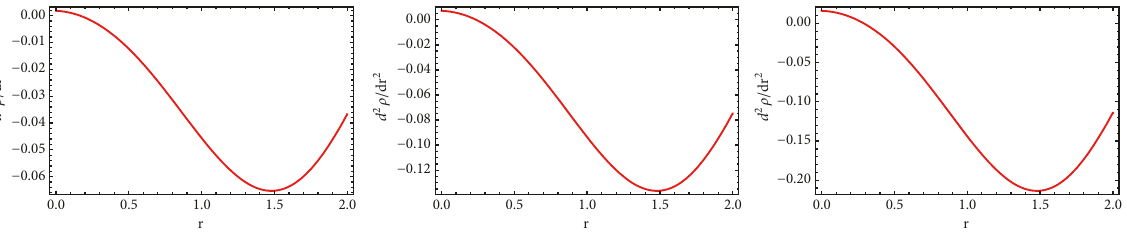
Figure 8: This figure represents the variation of 𝑑 2 𝜌/𝑑𝑟 2 versus 𝑟 (km) for the strange star taking 𝛽 = 1 , 𝛽 = 2 , and 𝛽 = 3 .